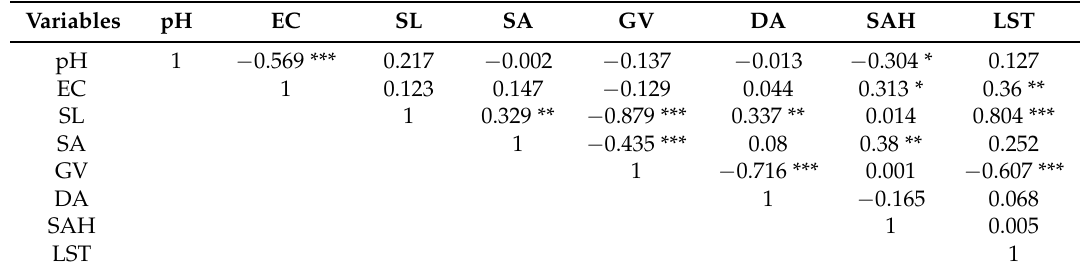
Table 3. Correlation coefficients of each pairwise variable at 38 sites.